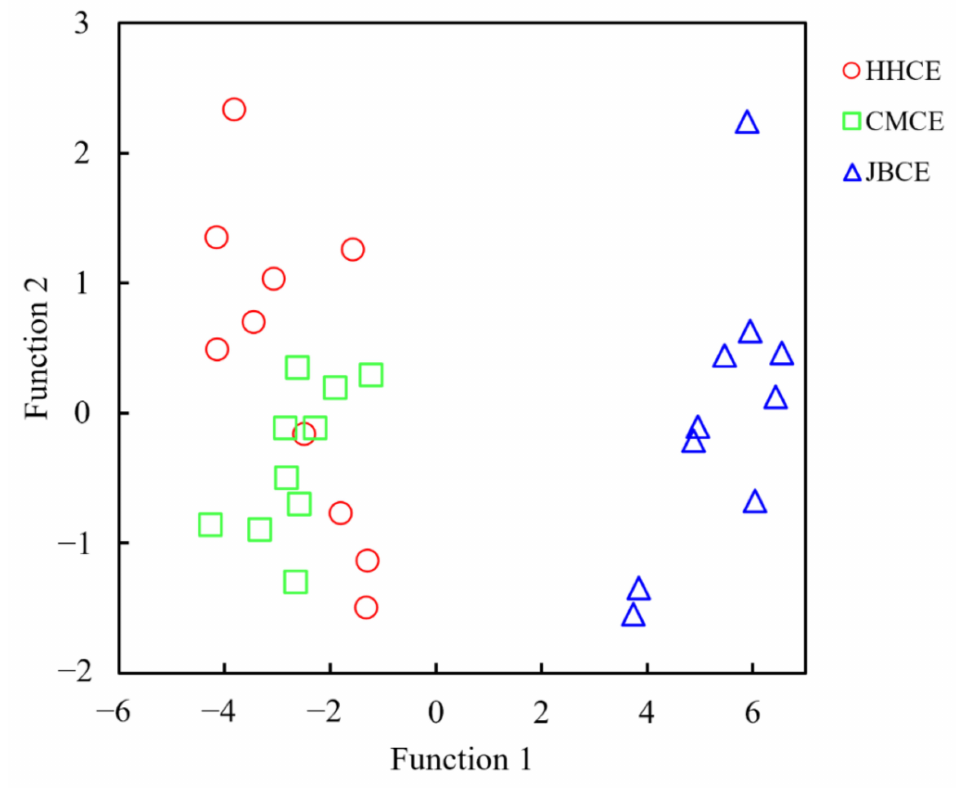
Figure 5. Discriminant analysis of Coilia nasus from the Nantong coastal area of the Yellow Sea (HHCE), the Changjiang estuary near the Jiuduansha Shoal (CMCE), and the Jiubao bridge waters in the Qiantang estuary (JBCE), based on microchemical characteristics of the otolith core. Those of HHCE and CMCE were mixed, while those of JBCE were independent from the